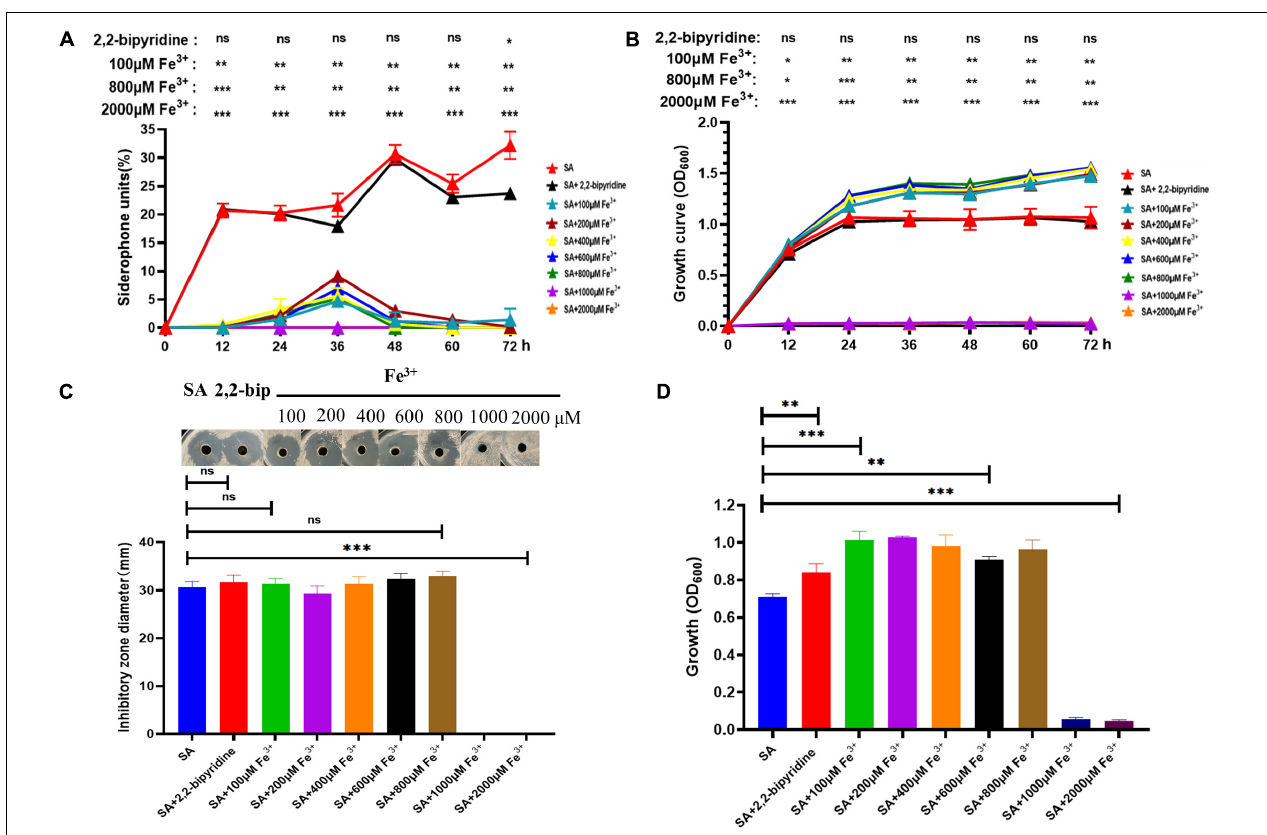
FIGURE 4 | Growth curve, siderophore production, and bacteriostasis of AS19 at different Fe 3 + concentrations. (A) Effect of different concentrations of Fe 3 + on AS19 siderophore production. AS19 was cultured in SA medium containing different concentrations of Fe 3 + at 30 ◦ C and 200 rpm. (B) Effect of different concentrations of Fe 3 + on AS19 growth. AS19 was inoculated into SA medium containing different concentrations of Fe 3 + at 30 ◦ C and 200 rpm. (C) Effect of different concentrations of Fe 3 + on AS19 bacteriostatic activity. AS19 was inoculated into SA medium containing different concentrations of Fe 3 + at 30 ◦ C and 200 rpm for 48 h. One milliliters of bacterial solution were centrifuged at 12,000 rpm for 10 min. The CFS was used for the plate bacteriostasis test. (D) Effect of different concentrations of Fe 3 + on AS19 growth at 48 h. (ns, no significant difference, ∗ p < 0.05, ∗∗ p < 0.01, ∗∗∗ p <